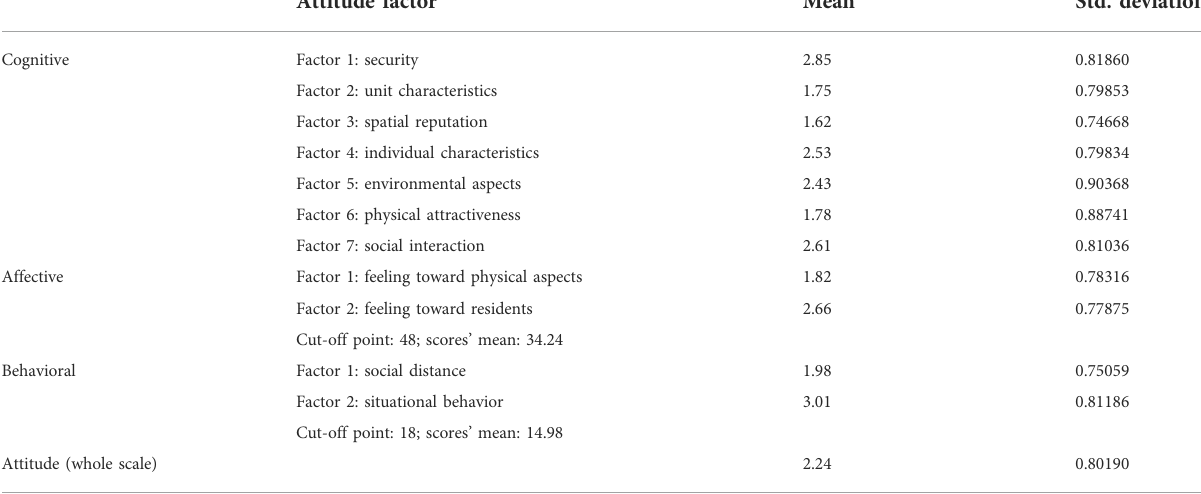
TABLE 3 Scale and factor description: Mean and standard